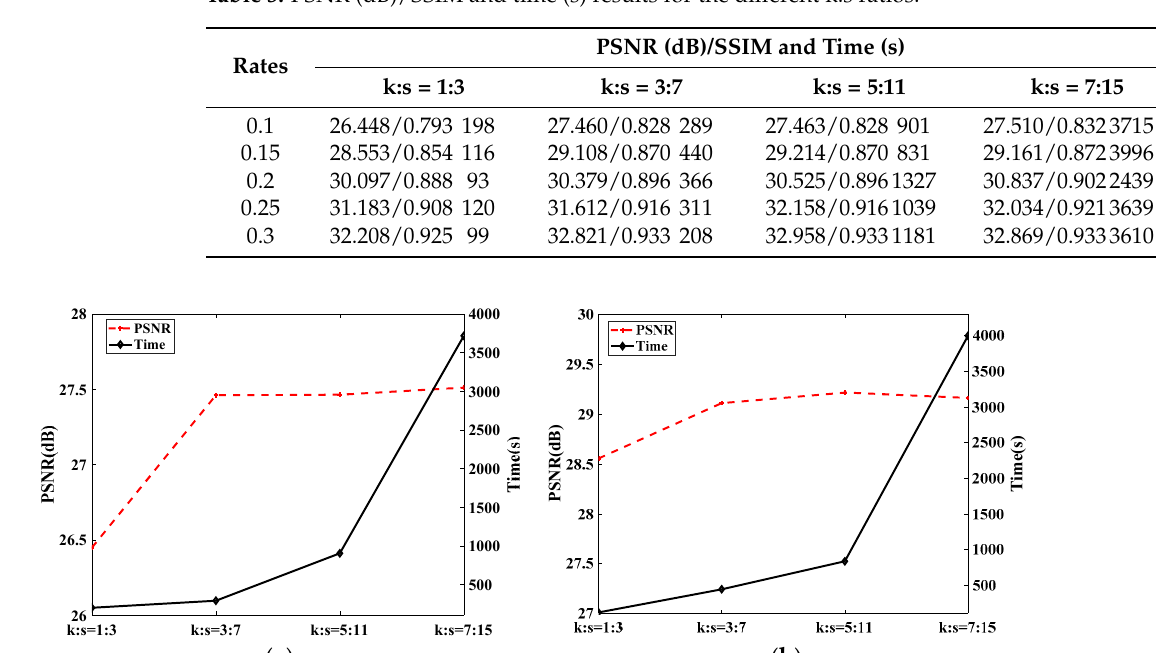
Table 3. PSNR (dB)/SSIM and time (s) results for the different k:s ratios.